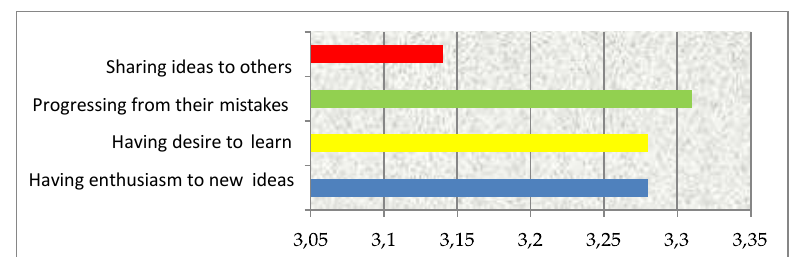
Figure 5. Students’ motivation for online learning